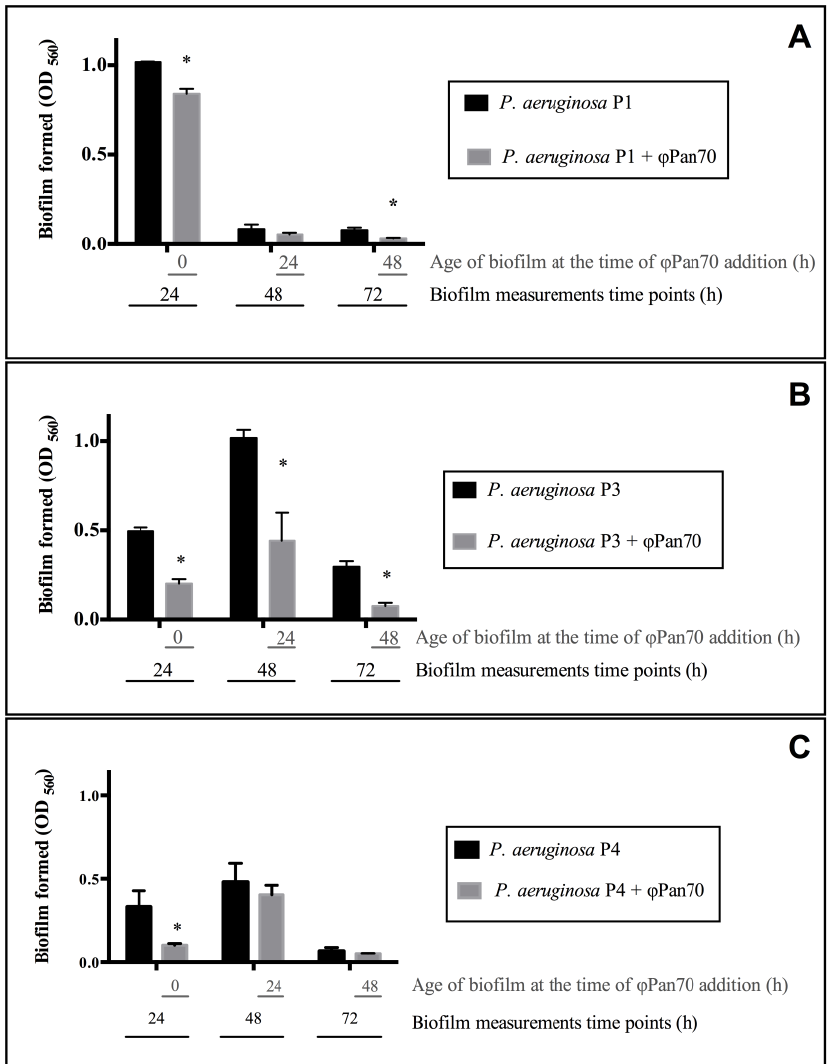
Figure 3. ΦPan70 prevents and removes biofilms of Pseudomonas aeruginosa MDR strains P1, P3 and P4. Bacterial biofilm formation with ( grey bars ) and without ( black bars ) ΦPan70. In all cases phage addition prevented or removed the biofilm of the three strains assayed, with significant differences ( p < 0.05) compared to controls for some dataset (marked with asterisks) although different patterns were observed according to the strain. Phage was added at different times (0, 24 and 48 h) after bacteria inoculation in the 96-well plate. On the x axis, black numbers correspond to the time at which measurements of the biofilm formed were taken (24, 48 and 72 h), while the grey numbers correspond to the age of the culture or biofilm at which phage ΦPan70 was added. MOI was 0.001 in all cases. ( A ) P. aeruginosa P1; ( B ) P. aeruginosa P3; ( C ) P. aeruginosa P4. Each bar represents the mean ± SD of triplicate experiments.